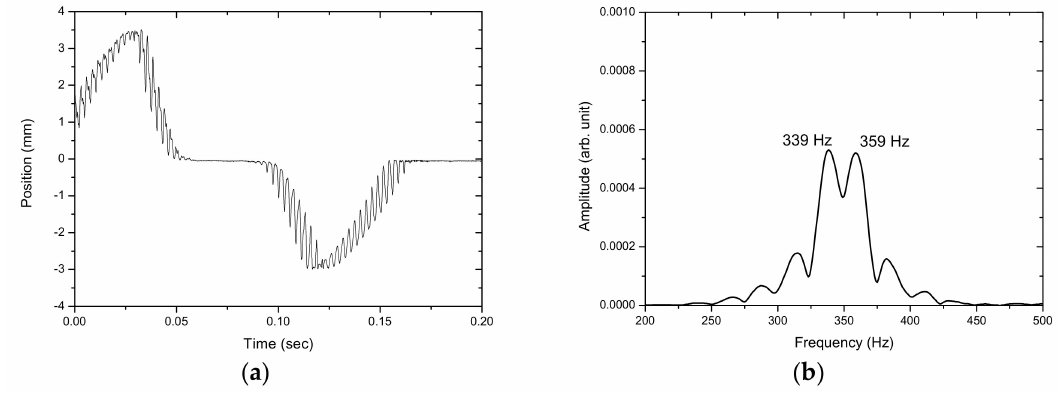
Figure 12. ( a ) The PSD-detected signal and ( b ) the frequency spectrum of the motion of the vibrating string at 4.8 × 10 − 2 m/s.